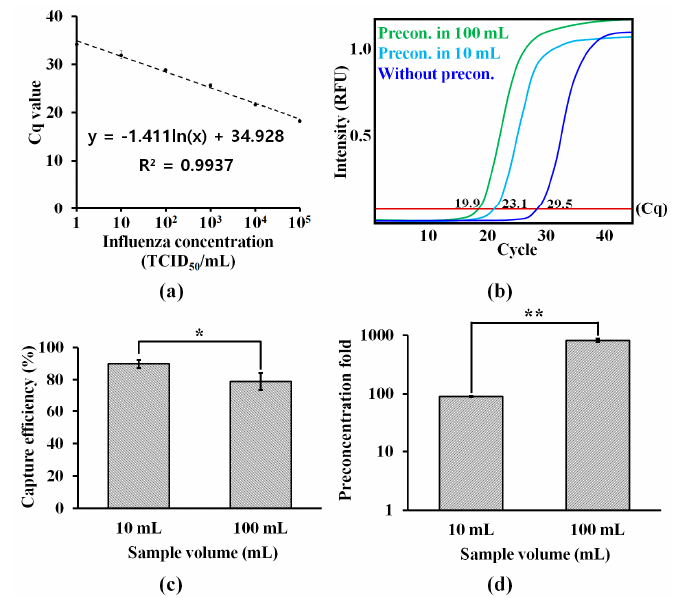
Figure 3. Quantitative reverse transcriptase-polymerase chain reaction (qRT-PCR) assays for evaluating the performance of the on-chip preconcentration. ( a ) A standard curve for H1N1 at di ff erent concentrations (1–10 5 TCID50 (50% tissue culture infective dose) / mL) in phosphate-bu ff ered saline (PBS). The Cq values plotted for each concentration are the mean of three replicates. ( b ) On-chip preconcentration of influenza virus H1N1 in di ff erent volume of samples containing 10 2 TCID50 / mL. ( c ) E ff ect of sample volume on viral capture e ffi ciency. ( d ) Preconcentration fold. *: p < 0.05. **: p < 0.01. Student’s t -test. Sample number = 3.